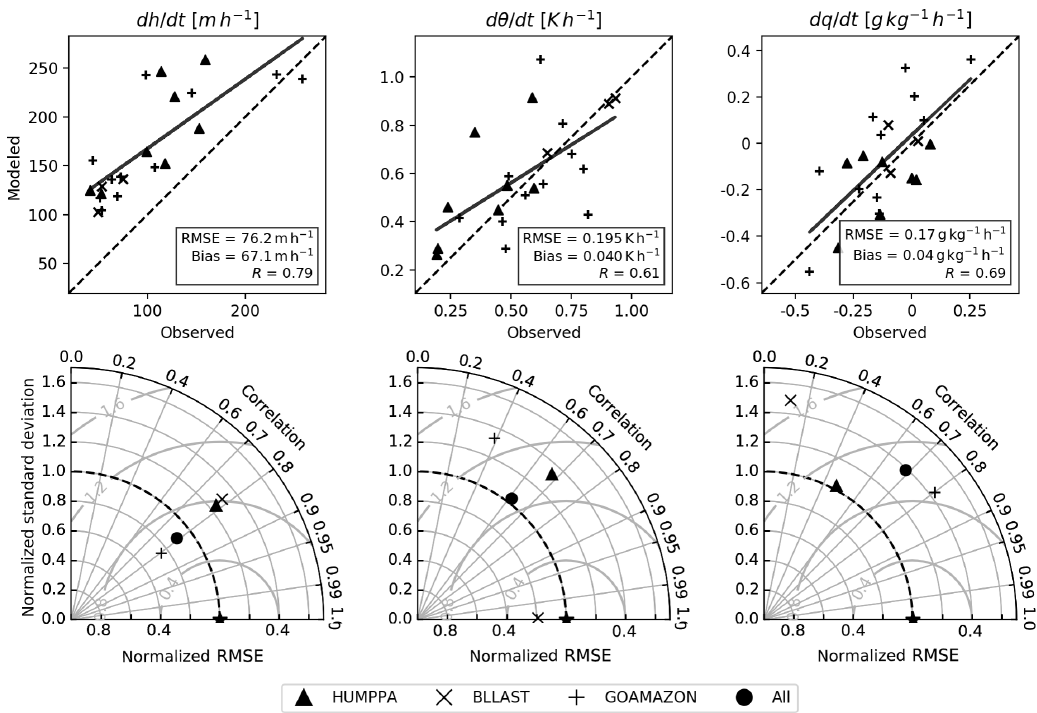
Figure 3. Performance statistics of diurnal changes in mixed-layer properties (mixed-layer height: d h/ d t ; potential temperature: d θ/ d t ; specific humidity: d q/ d t ) during the three intensive observation campaigns: HUMPPA, BLLAST and GOAMAZON. The 1 : 1 line is shown as a black dashed